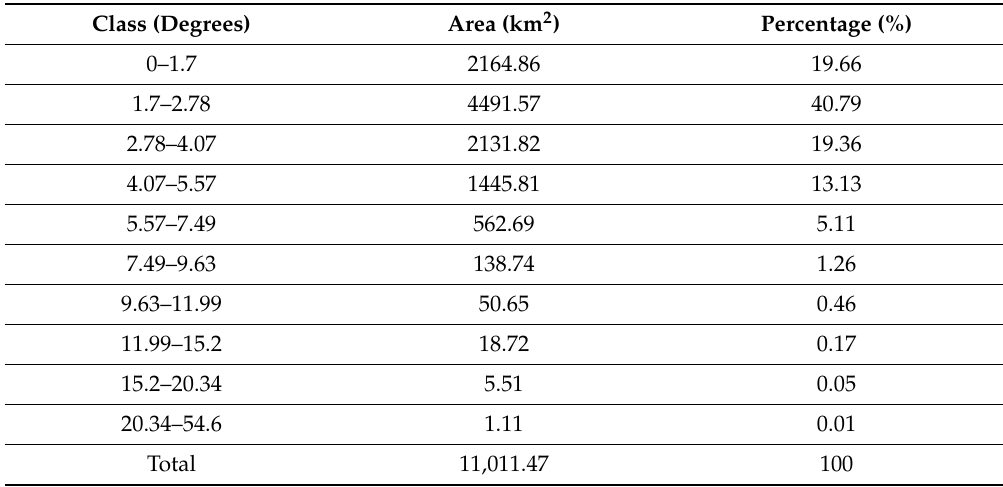
Table 12. Slope analysis results for Al-Shamal train pathway in Al-Qurayyat city in